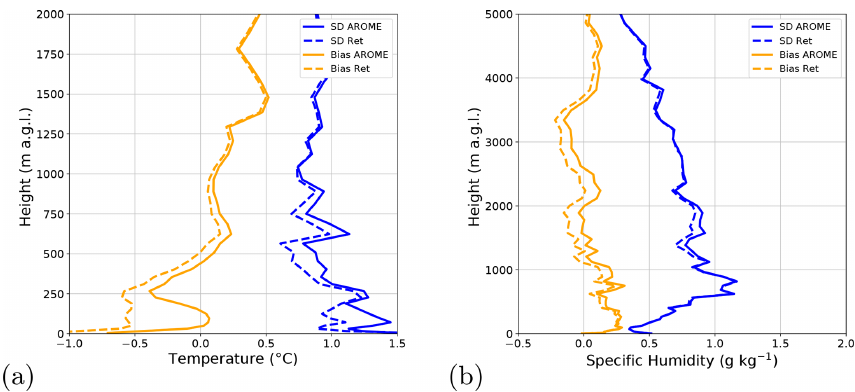
Figure 12. RMSE and bias of (a) temperature retrievals and (b) specific humidity retrievals relative to radiosonde observations. These were made throughout the SOFOG-3D field campaign between 1 December 2019 and 12 March 2020 and consisted of 51 radiosonde launches. Solid lines correspond to the background profile, and dashed lines correspond to retrieved profile statistics. Blue lines denote the standard deviation of errors, and yellow lines show the